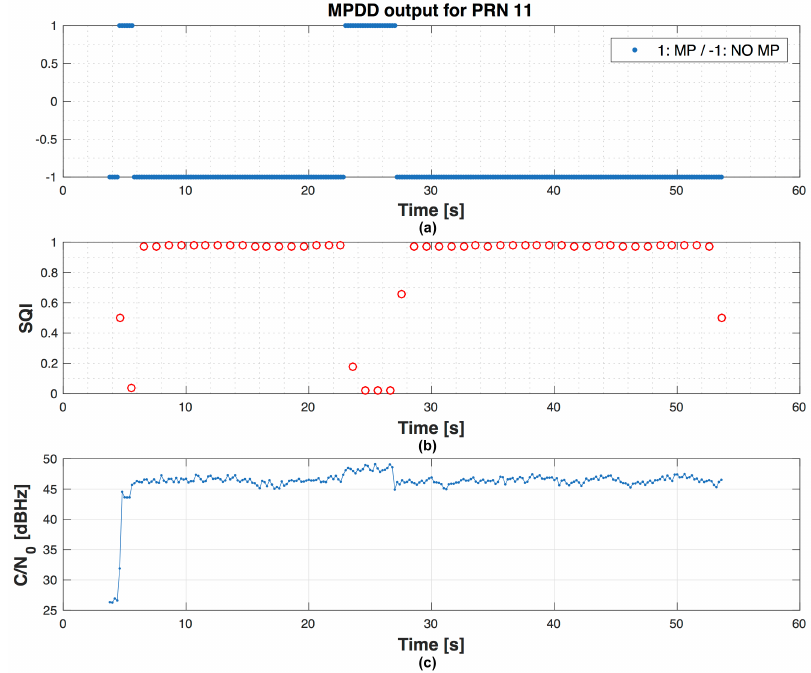
Figure 12. Example related to PRN 11 in scenario 1: the MPDD output ( a ); the SQI ( b ) and the C / N 0 trend ( c